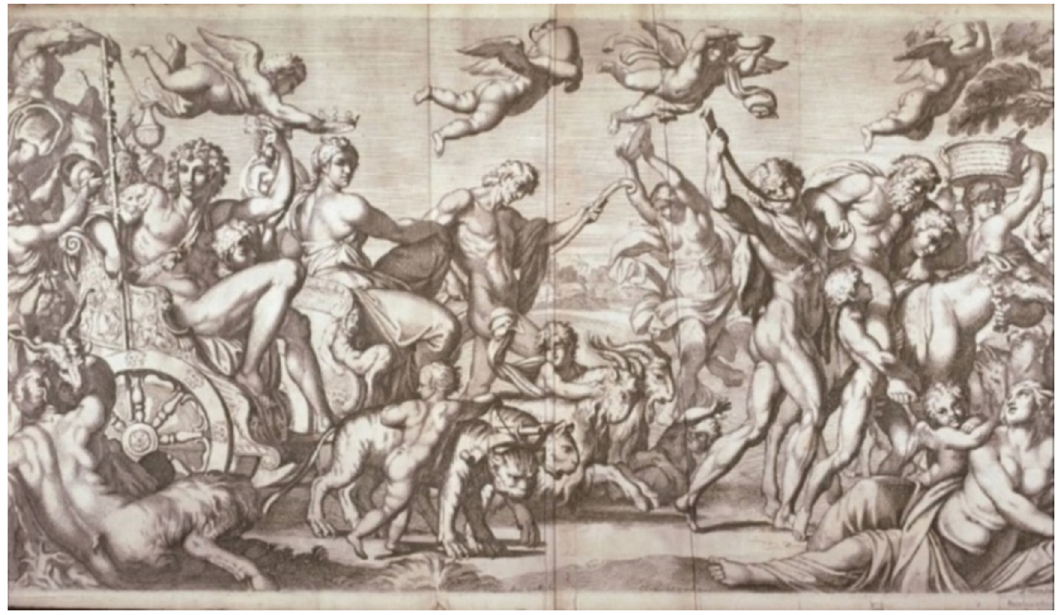
Figure 25: Cesius after Carracci, The triumph of Bacchus and Ariadne , 1595. Queensland Art Gallery. Public